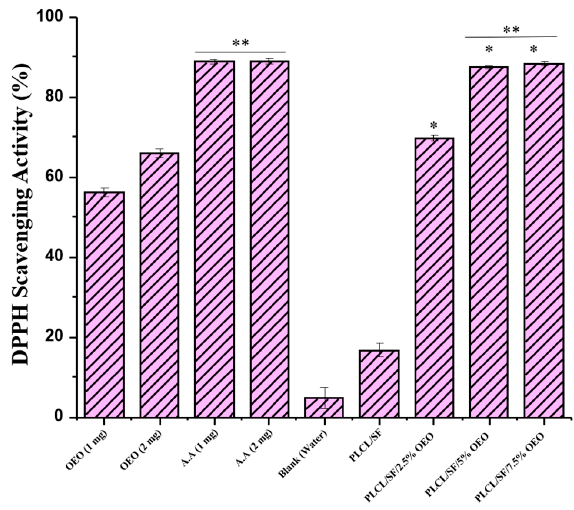
Figure 7. 2,2-diphenyl-1-picryl-hydrazyl-hydrate (DPPH) scavenging activity of various samples for 30 min time. (* = significant difference in comparison with PLACL/SF, ** = non-significant with each other).